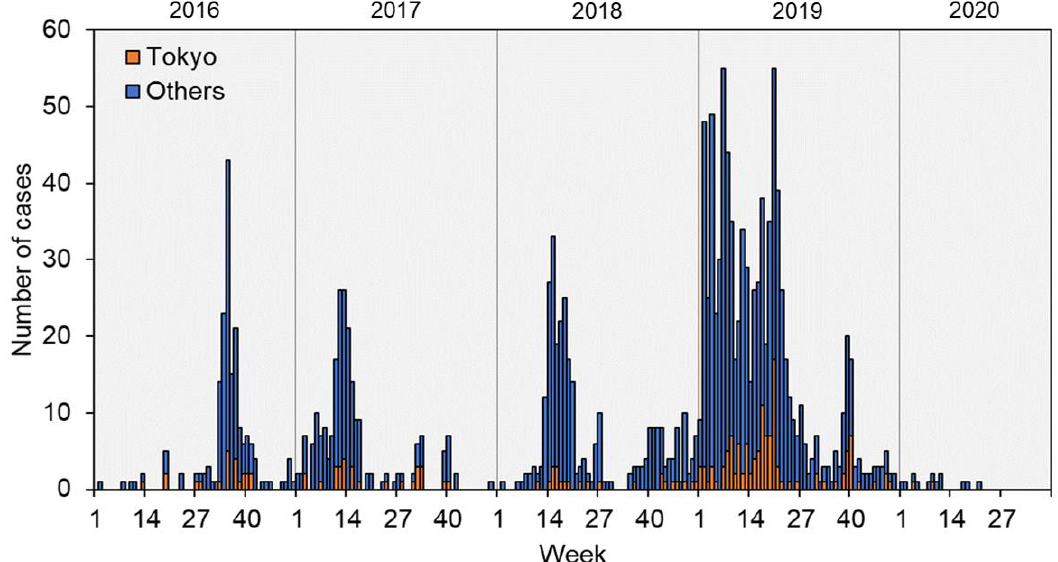
Figure 1. Epidemiological trend of measles in Tokyo and all of Japan, by week, in 2016–2020. The orange represents the number of reported measles cases in Tokyo, while the blue indicates reported measles cases outside Tokyo. In 2020, only weeks 1–39 are shown due to the availability of data.